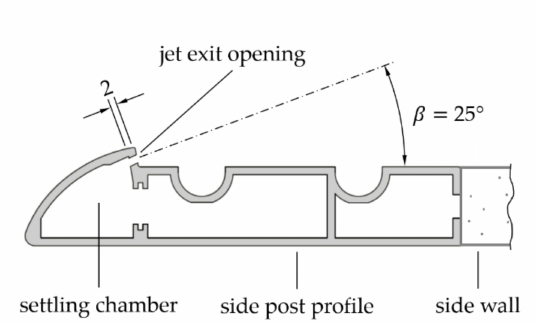
Figure 6. Jet exit at the side post profile, baseline fume hood, sectional drawing.